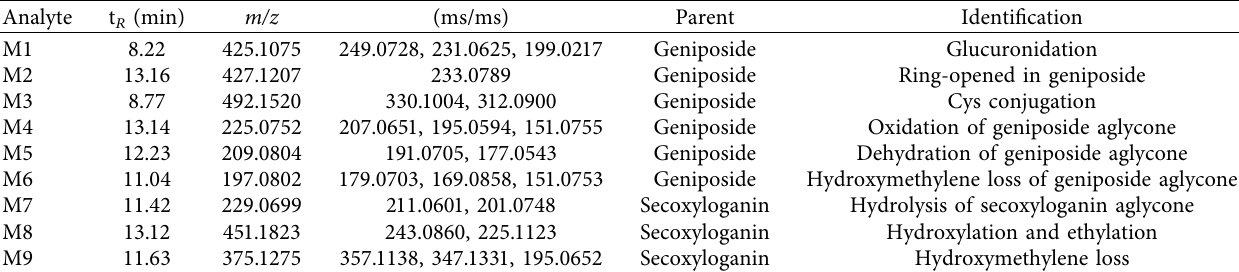
Figure 6: The representative extract ion chromatograms of nine metabolites: (a) blank plasma and (b) 1 h plasma sample after intravenous administration of RDN. Table 7: The related MS data of nine